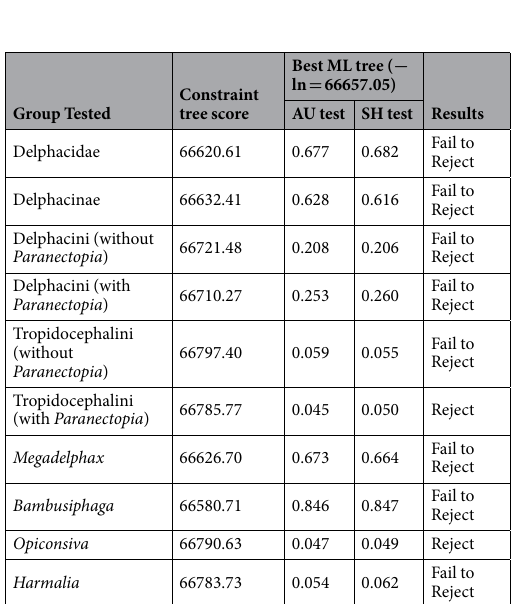
Table 2. The primers of 28S rDNA, 16S rDNA, cox1 and cytb genes.